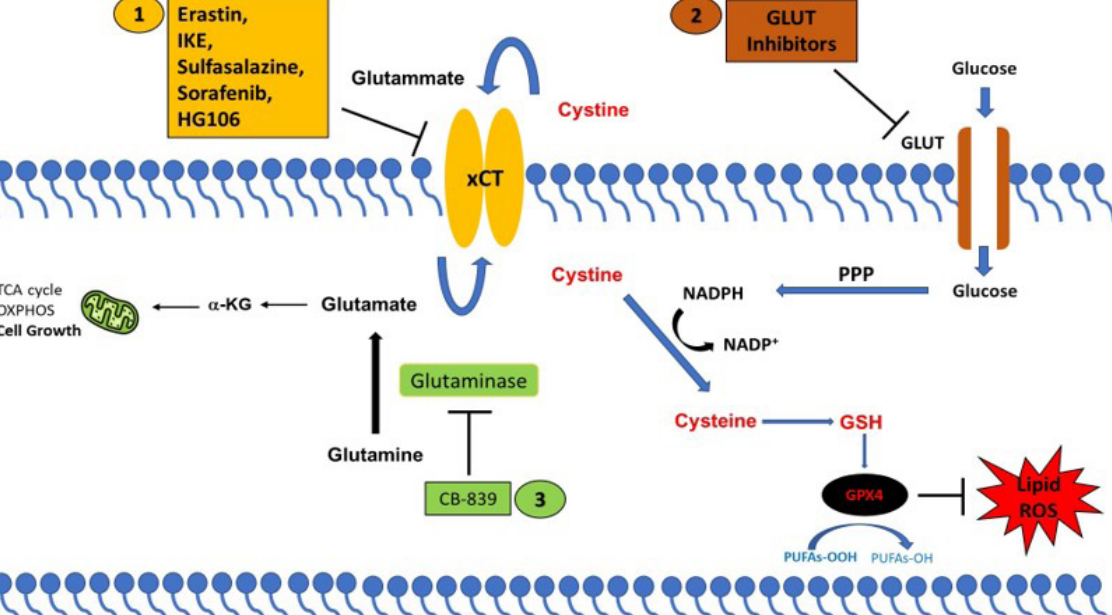
Figure 1. xCT-based therapeutic strategies. Strategies to target cancer cells with high xCT expression. (1) Direct inhibition of xCT; or by targeting xCT-associated metabolic vulnerabilities using (2) GLUT inhibitors and (3) glutaminase inhibitors (CB-839). PPP: pentose phosphate pathway; α-KG: